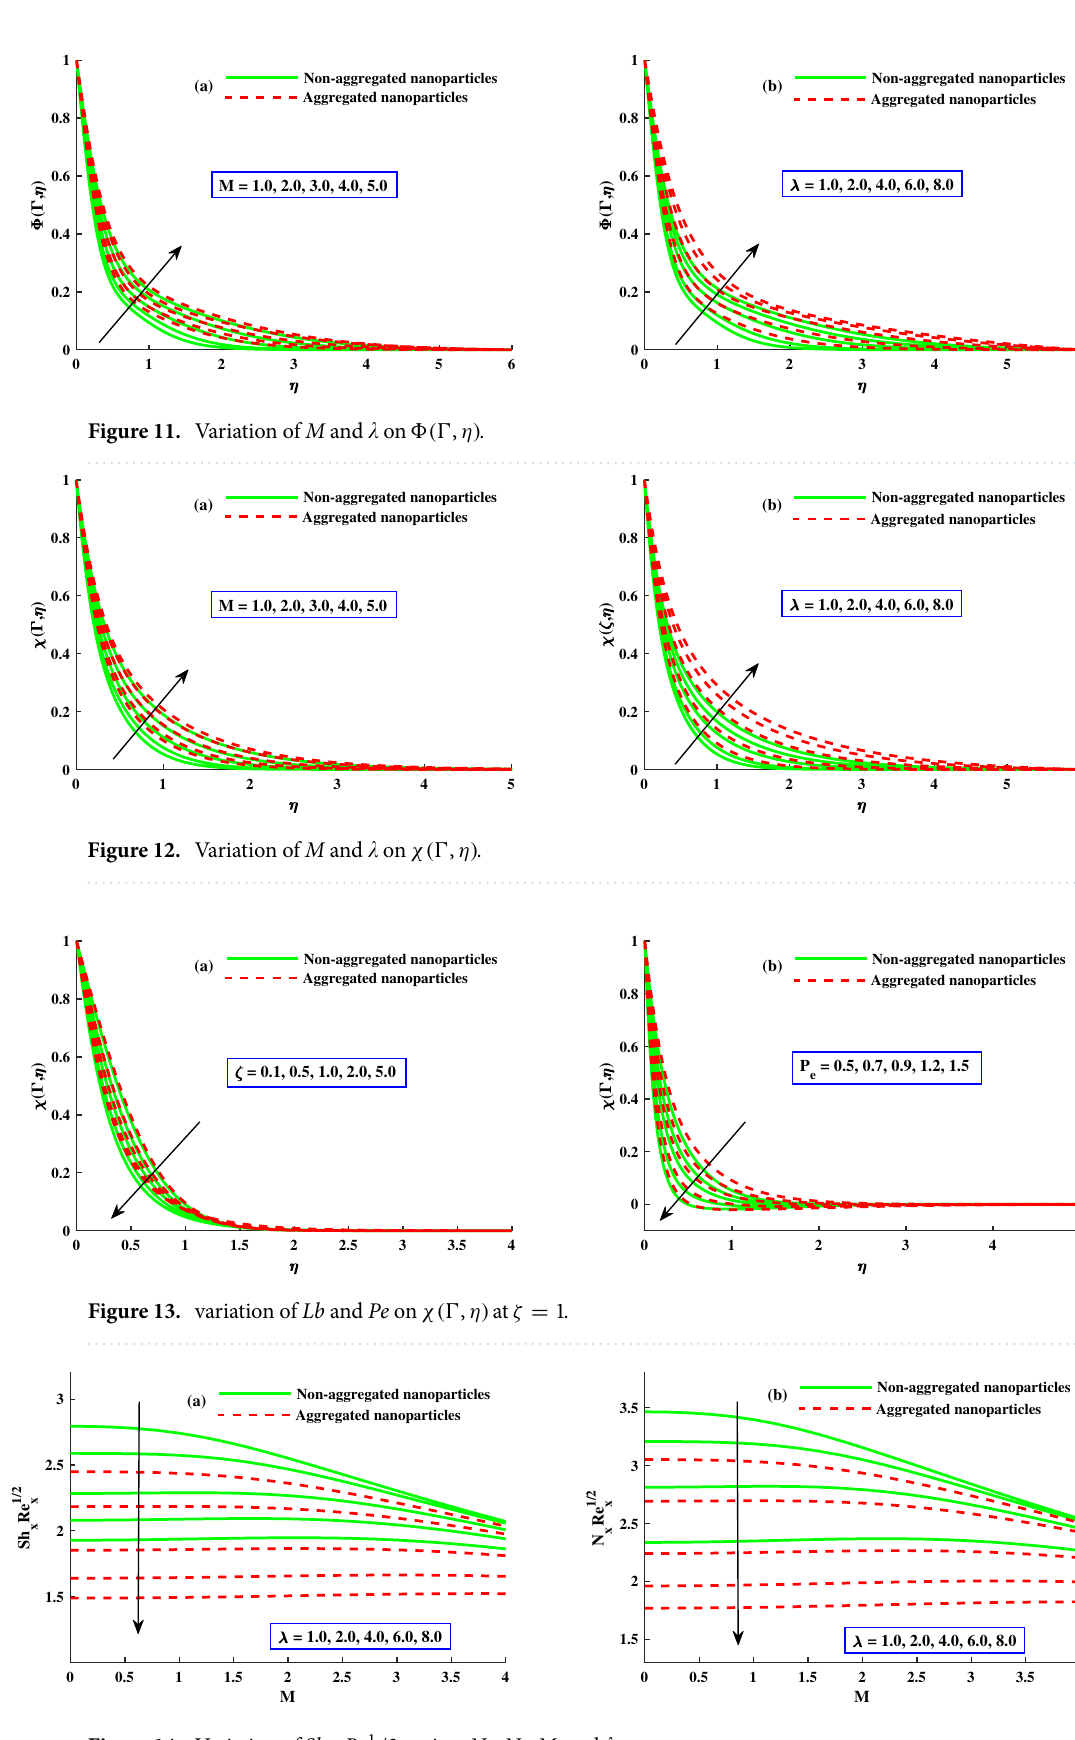
Figure 14. Variation of Shr x Re 1 x / 2 against N b , N t , M , and (cid:31)